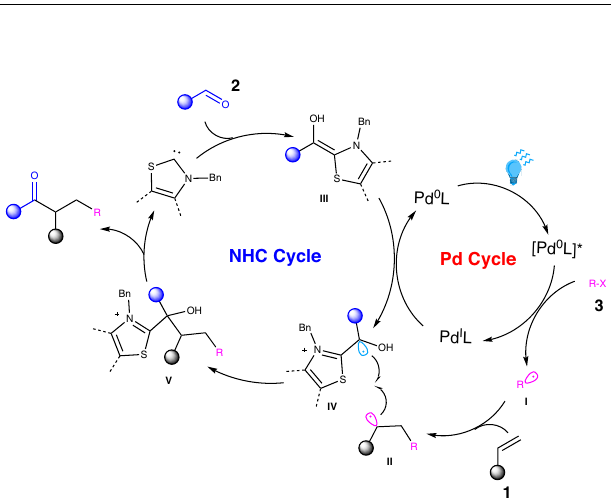
Fig. 9 | Proposed catalytic cycle. The plausible mechanism for the photoredox cooperative NHC/Pd catalylsed alkylacylation of